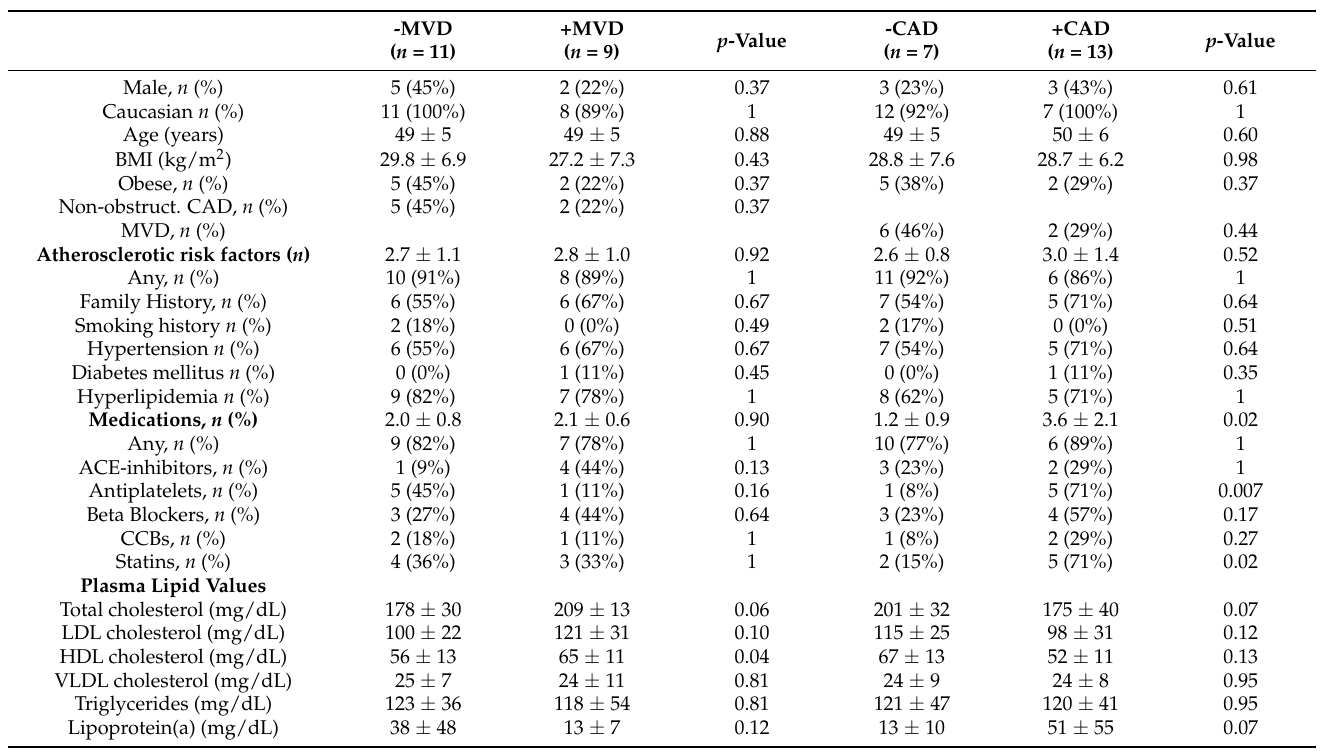
Table 3. Clinical characteristics and plasma lipid values stratified by presence of microvascular dysfunction (MVD) and non-obstructive